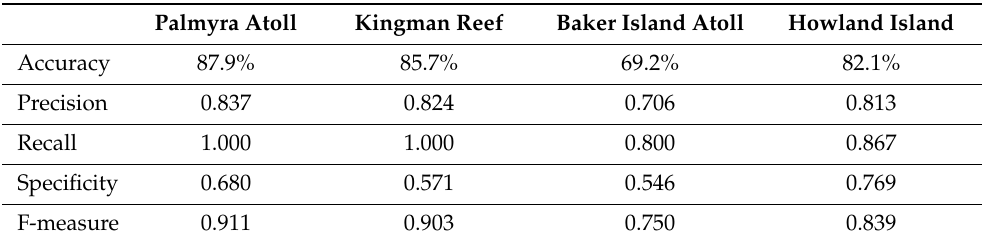
Table 3. SVM classifier performance assessment by site.